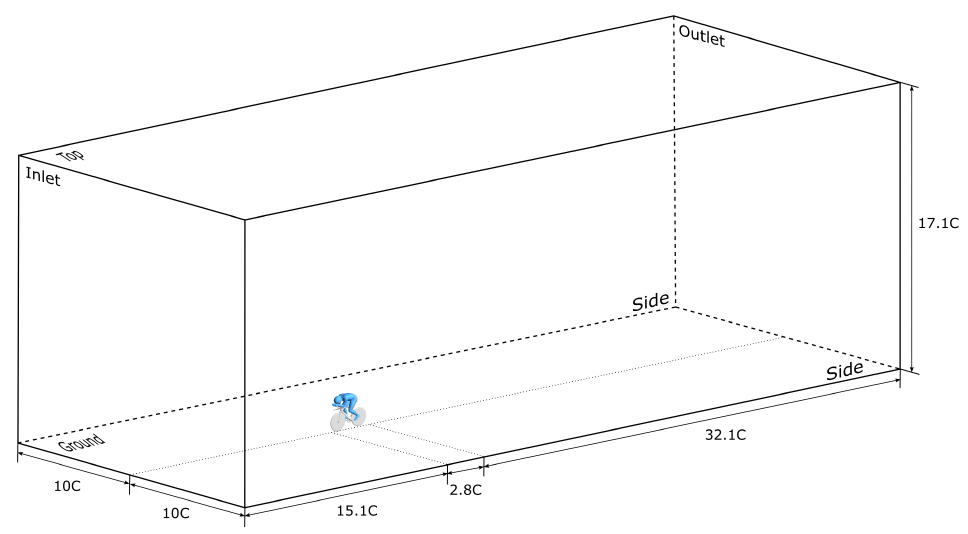
Figure 1. Illustration of CFD rider/bicycle geometries: 1a,1b and 2a,2b represent sprint ( top row ) and pursuit ( bottom row ) postures with horizontal ( left column ) and vertical ( right column ) leg positions respectively.